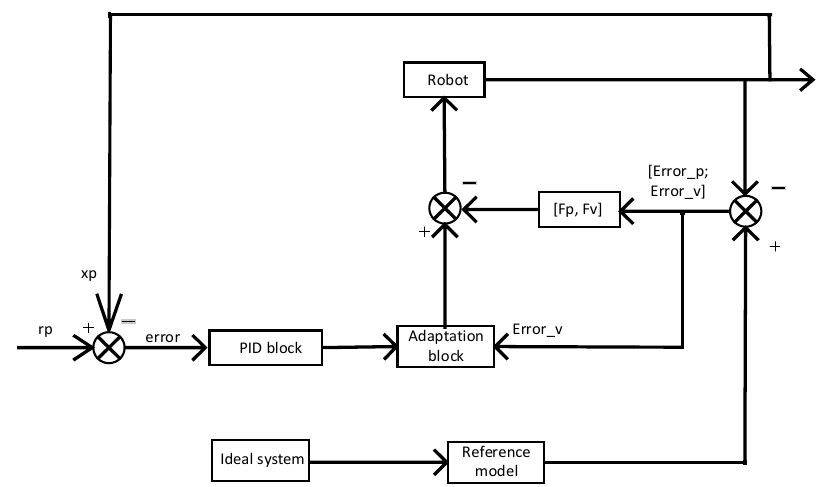
Figure 9. Control system for more than 1-DOF linkage.